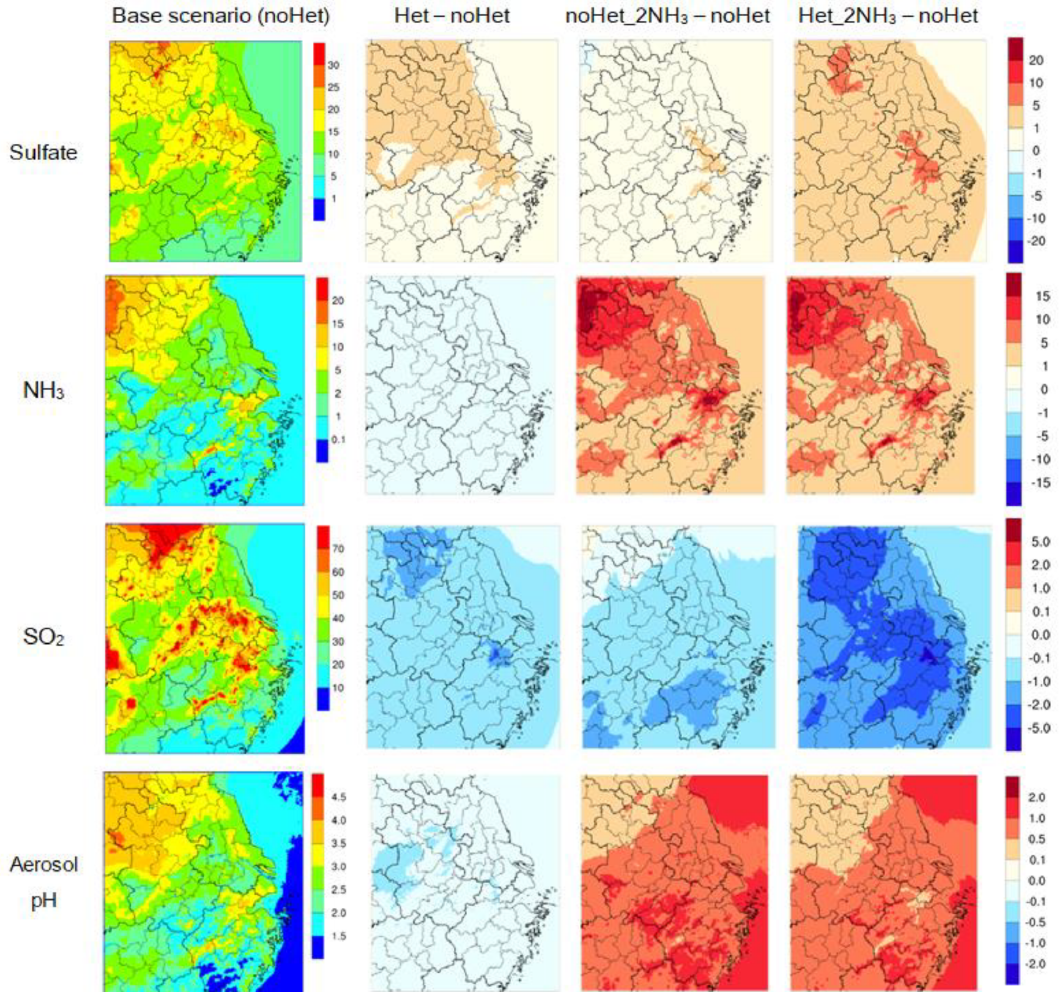
Figure 9. Spatial distribution of simulated monthly sulfate (top row), NH 3 (second row), and SO 2 (third row) concentrations (µgm − 3 ) and aerosol pH (bottom row) over the YRD region for the base case scenario (first column) and the differences (µgm − 3 for concentrations) between the base case and other three scenarios: Het (second column), noHet_2NH 3 (third column), and Het_2NH 3 (fourth